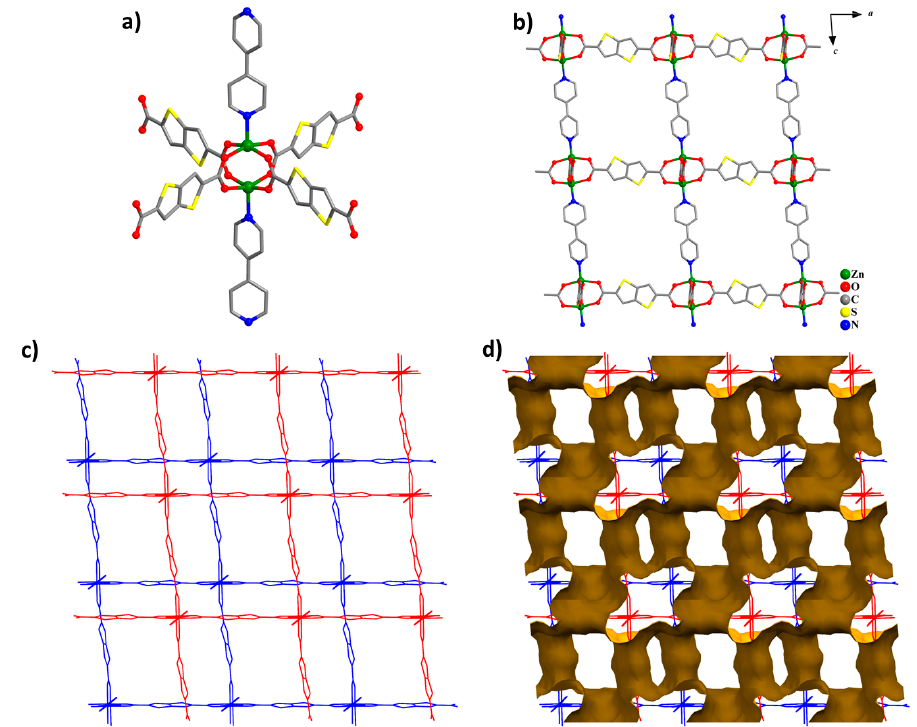
Figure 1. (a ) {Zn 2 (COO) 4 N 2 } “paddle-wheel” complex in 1; ( b ) the framework structure of 1 in the ac plane; ( c ) two interpenetrated networks in 1 in the ab plane; ( d ) pore structure of 1 in the ab plane.